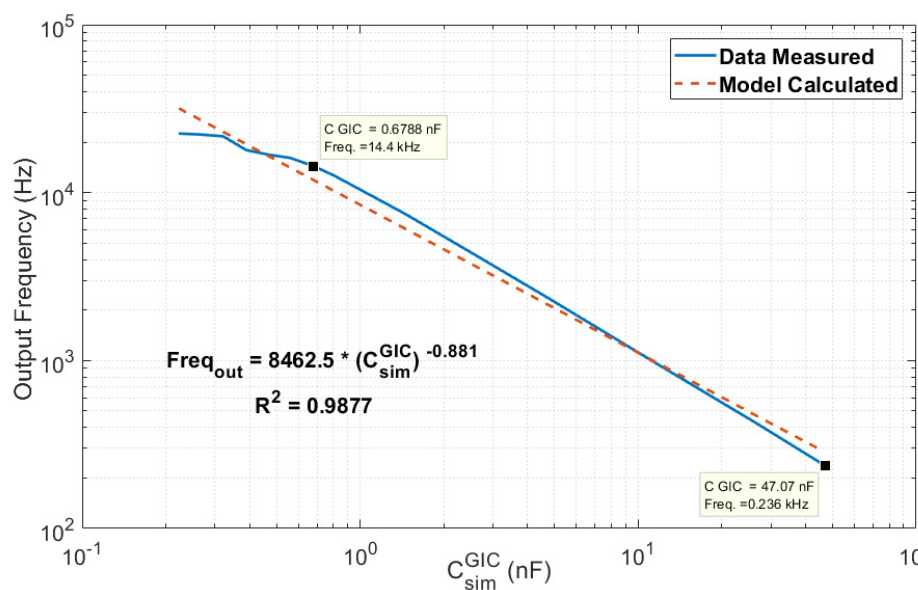
Figure 7. Capacitance simulated by Generalized Impedance Converter (GIC) versus frequency of the output signal of the design.